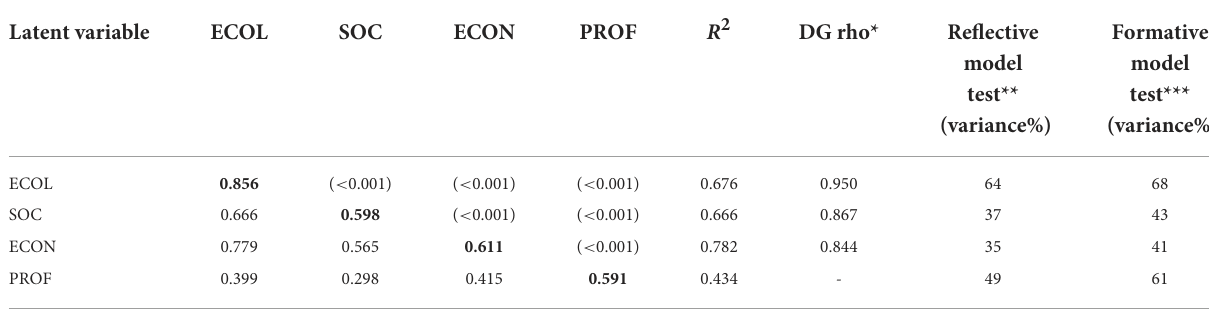
TABLE 5 Reliability measures of PLS-PM components. Latent variable